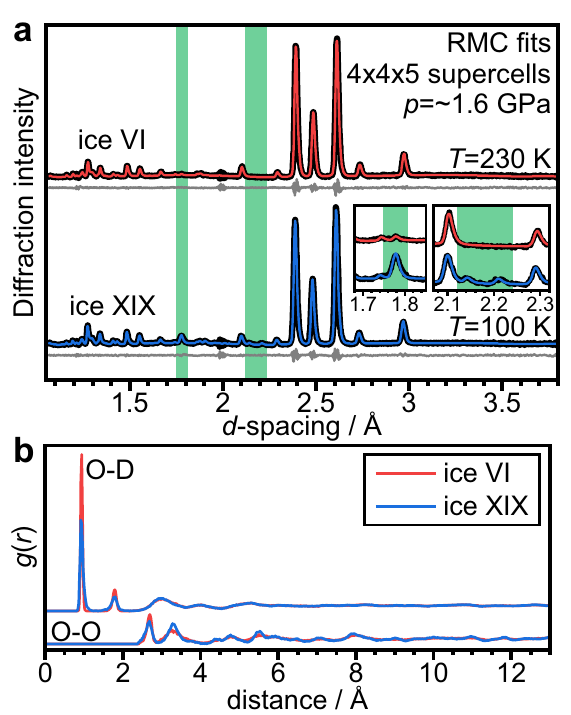
Fig. 4 Symmetry-free fi tting of the ice VI and ice XIX diffraction data with a Reverse Monte Carlo approach (RMCPro fi le) and a simple spring model to describe intra- and intermolecular bonding. a Fit to the diffraction data using hydrogen-disordered ice VI supercells containing 1500 D 2 O molecules. The green-shaded areas correspond to those shown in Fig. 2a and highlight the diffraction ranges where the most major intensity increase and the new Bragg peaks characteristic for ice XIX were observed. b Resulting O – D and O – O pair-distributions functions, g ( r ), for the two